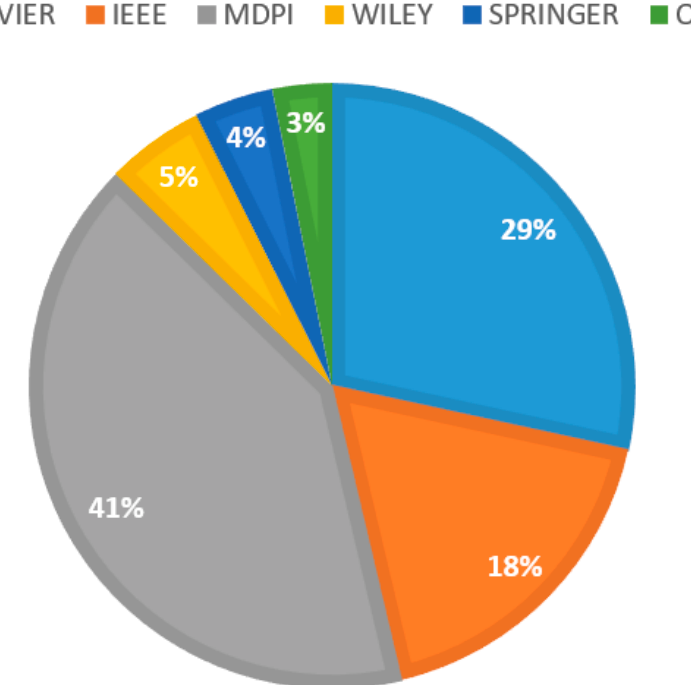
Figure 1. Results distribution by publisher.